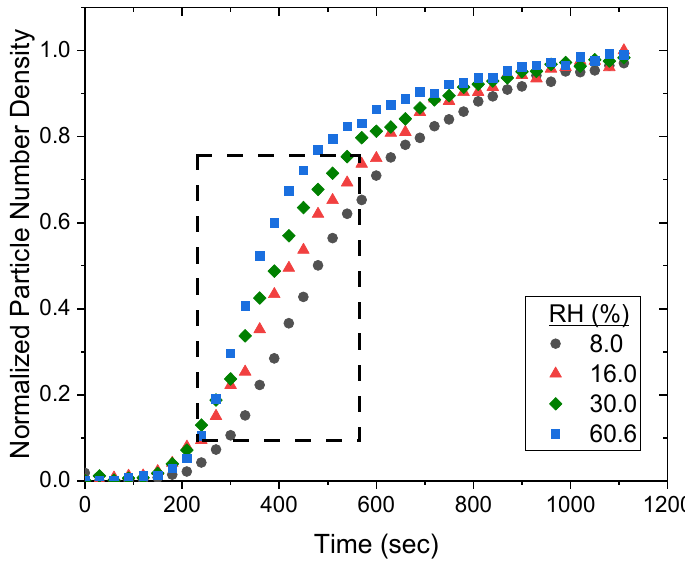
Figure 7. Normalized particle growth curves for ozonolysis of α -pinene at four RHs. The dashed box highlights the linear portion of each curve, where the normalized rate of formation (slope) was extracted for quantitative comparison.